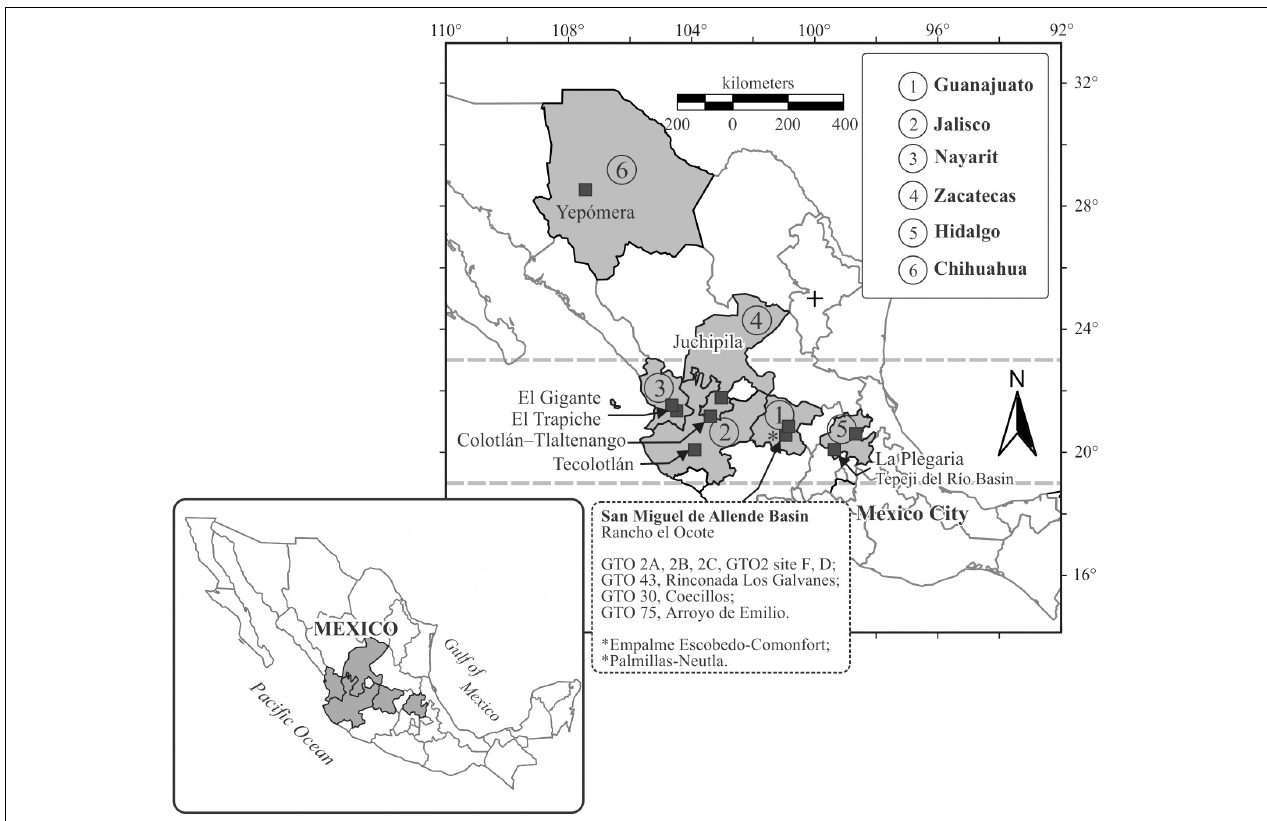
FIGURE 1 | On the map are the locations explained in the